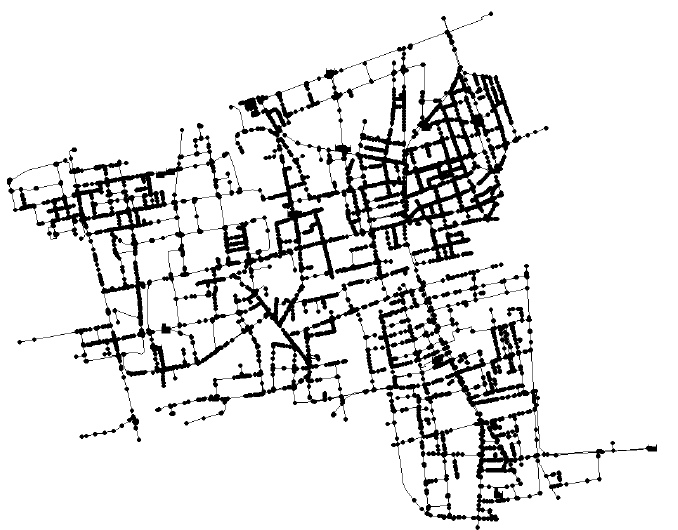
Figure 5. The graph of the BCM (Bresso–Cormano–Cusano-Milanino) network.